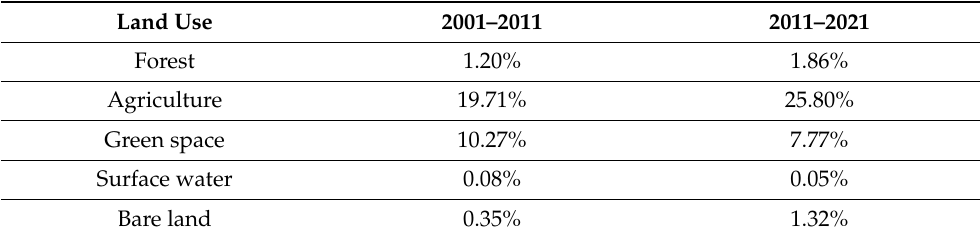
Figure 6. Extension of built-up area over 20 years in Kathmandu. Table 8. Transition from other land uses to built-up area.